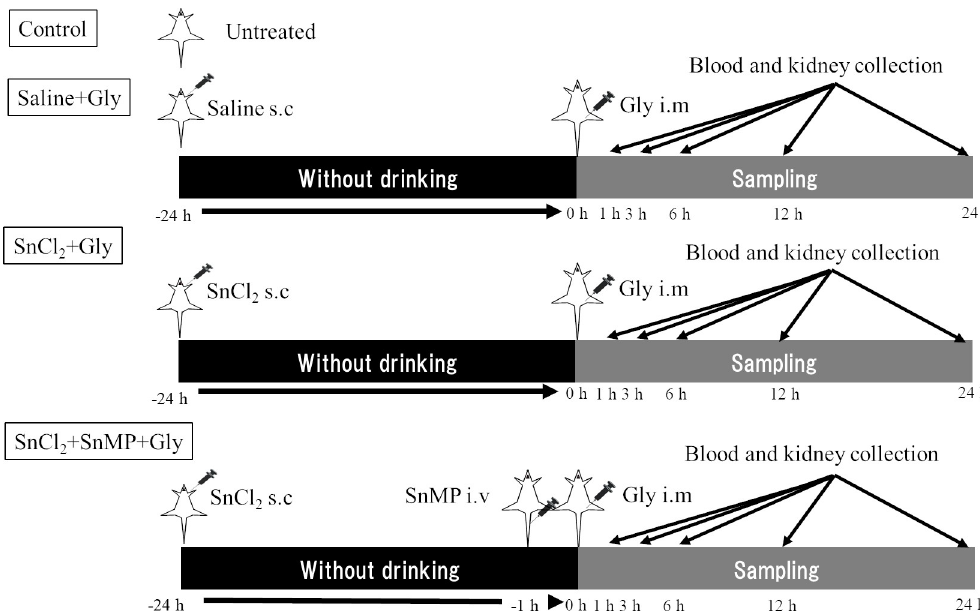
Fig 1. Experimental protocol and grouping. Rats were randomly divided into four groups: Control, saline+Gly, SnCl 2 +Gly, and SnCl 2 +SnMP+Gly. Rats in the control group were untreated. Rats in the other three group were treated with saline or SnCl 2 (s.c.) and then deprived of water for 24 h. Rats in the SnCl 2 +SnMP+Gly group received an additional treatment of SnMP (i.v.) 1 h before Gly injection. 24 h after saline or SnCl 2 treatment, rats were treated with Gly (i.m.); afterward, at five time points (1, 3, 6, 12, and 24 h) and their blood and kidneys